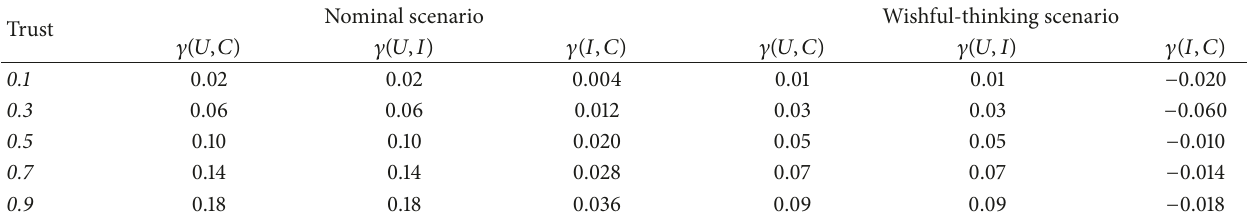
Table 2: Transition probabilities for PBM against different values of trust in both